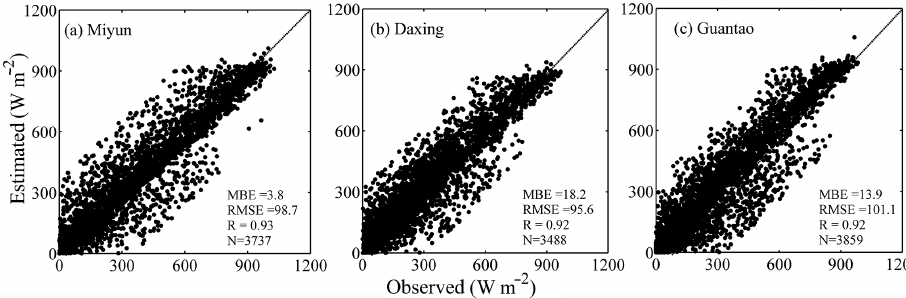
Figure 7. Comparison between the observed and the estimated hourly SSR at three experimental stations over the Haihe River basin in 2009. Units of MBE and RMSE are Wm − 2 . Points outside 3 σ were removed (about 1.88%).